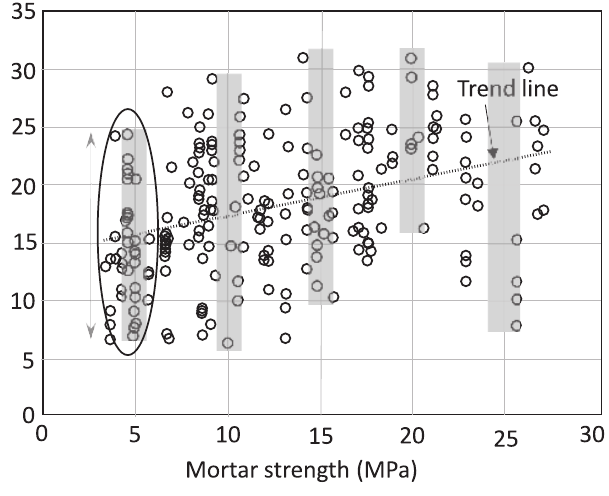
Figure 4 Masonry versus mortar strength adapted from Sarhat and Sherwood